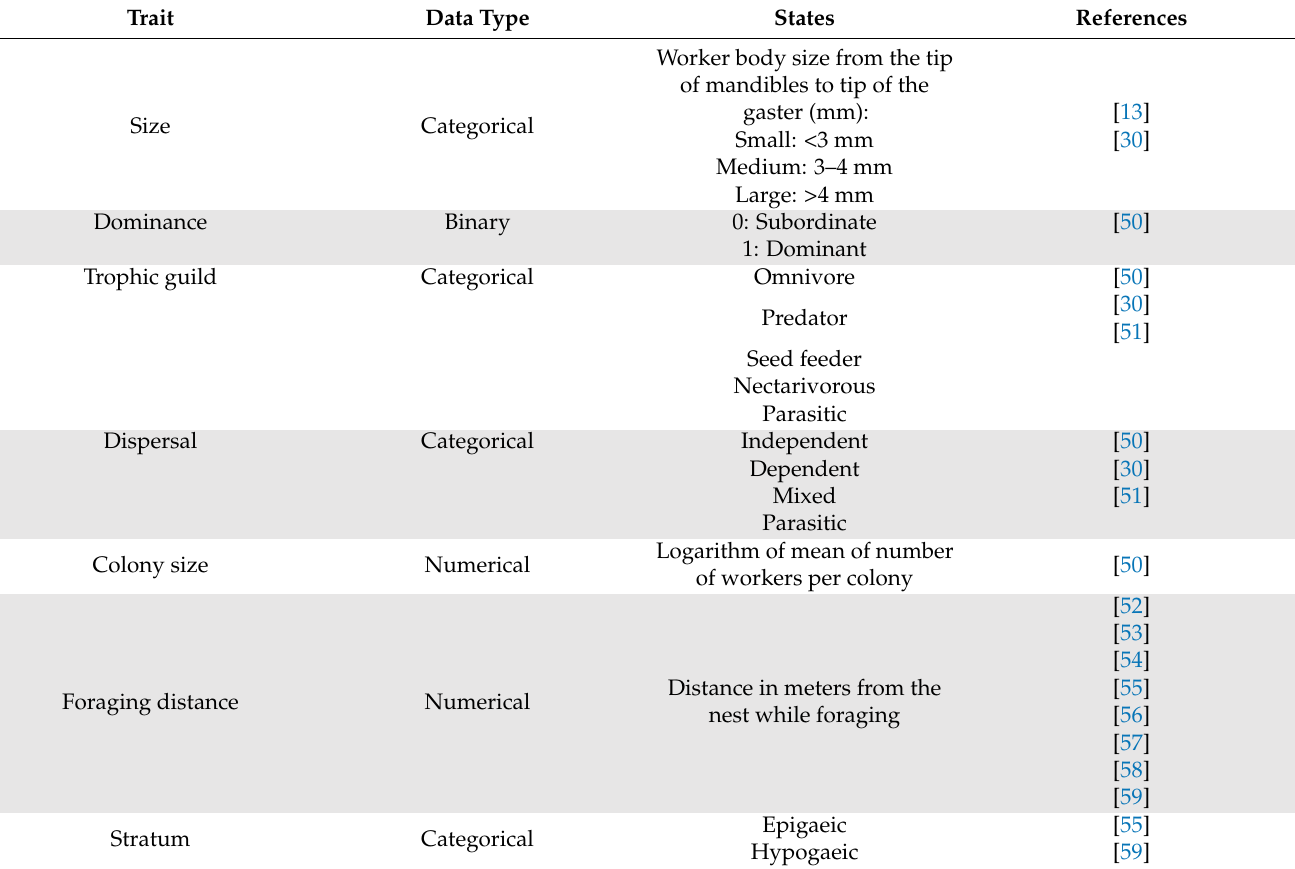
Table A2. Functional traits used and their